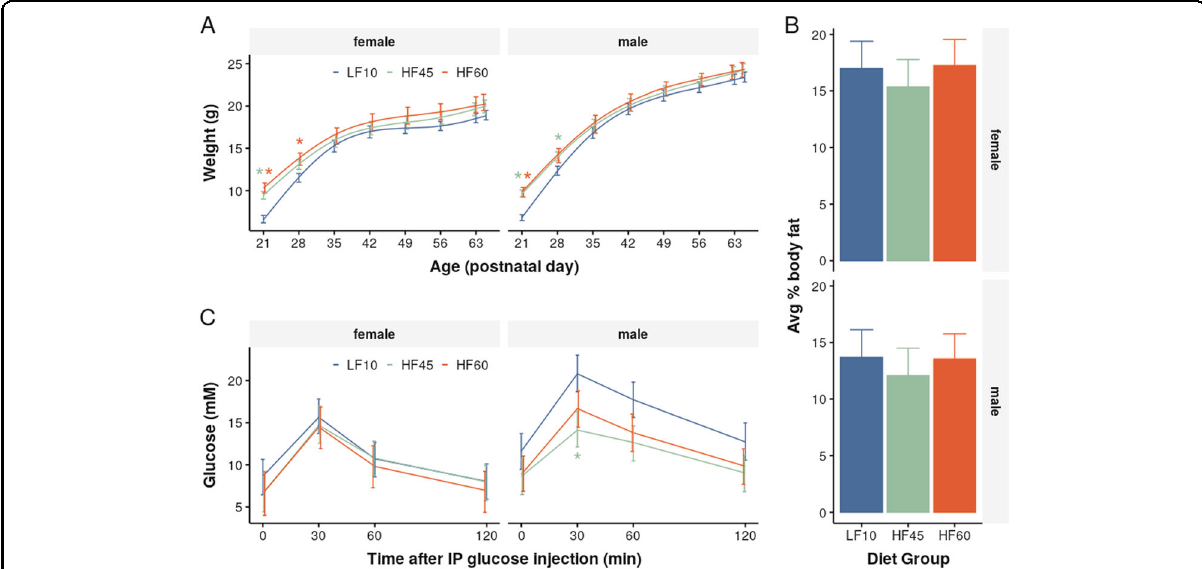
Fig. 3 Offspring exposed to maternal high-fat diets showed amelioration of metabolic effects when weaned to a low-fat diet. A Body weights of HF45/HF60 mice normalised after being weaned onto the low-fat diet. There was a signi fi cant diet-time interaction ( χ 2 12 = 71, p < 10 − 9 ) and con fi dence intervals of HF45/HF60 overlapped with LF10 mice after 2 weeks. B Body-fat composition, measured at P65, showed no signi fi cant effect of early-life diet ( F 2,63 = 1.20, p = 0.3). C GTT also showed no signi fi cant effect of early-life diet ( χ 2,16 = 23.6, p = 0.1). There was a decrease in blood glucose concentration 30 min after IP glucose administration in HF45 vs LF10 male offspring (difference = 6.63, p < 0.01). No signi fi cant decrease was found between the HF60 vs LF10 male offspring, and all female groups. All bars represent 95% con fi dence intervals. Asterisks represent a signi fi cant difference from LF10 ( p <